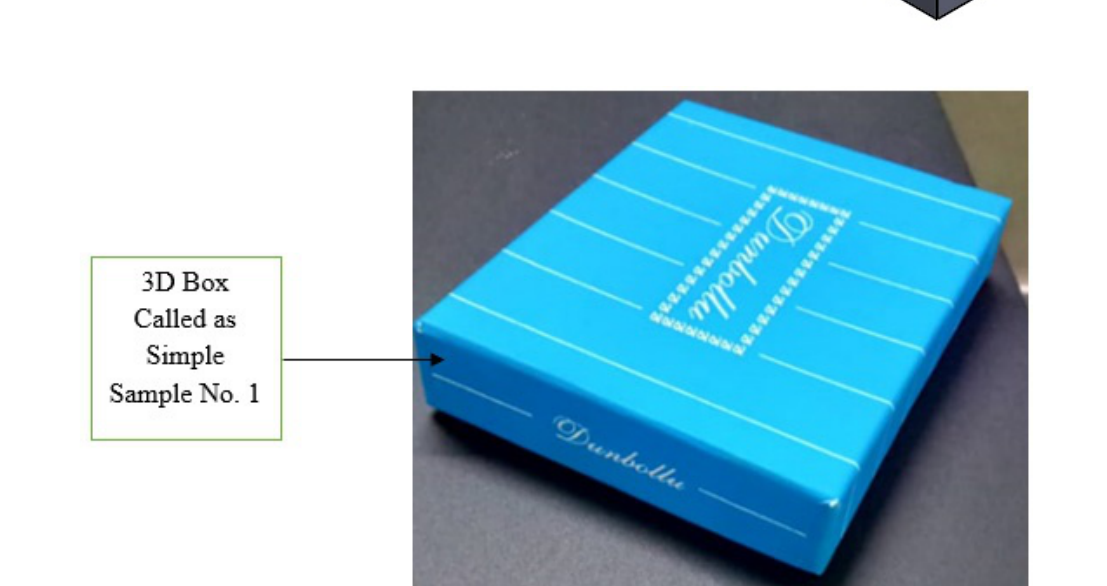
Figure 1. Geometric dimensions of Sample 1 (S1) (mm).